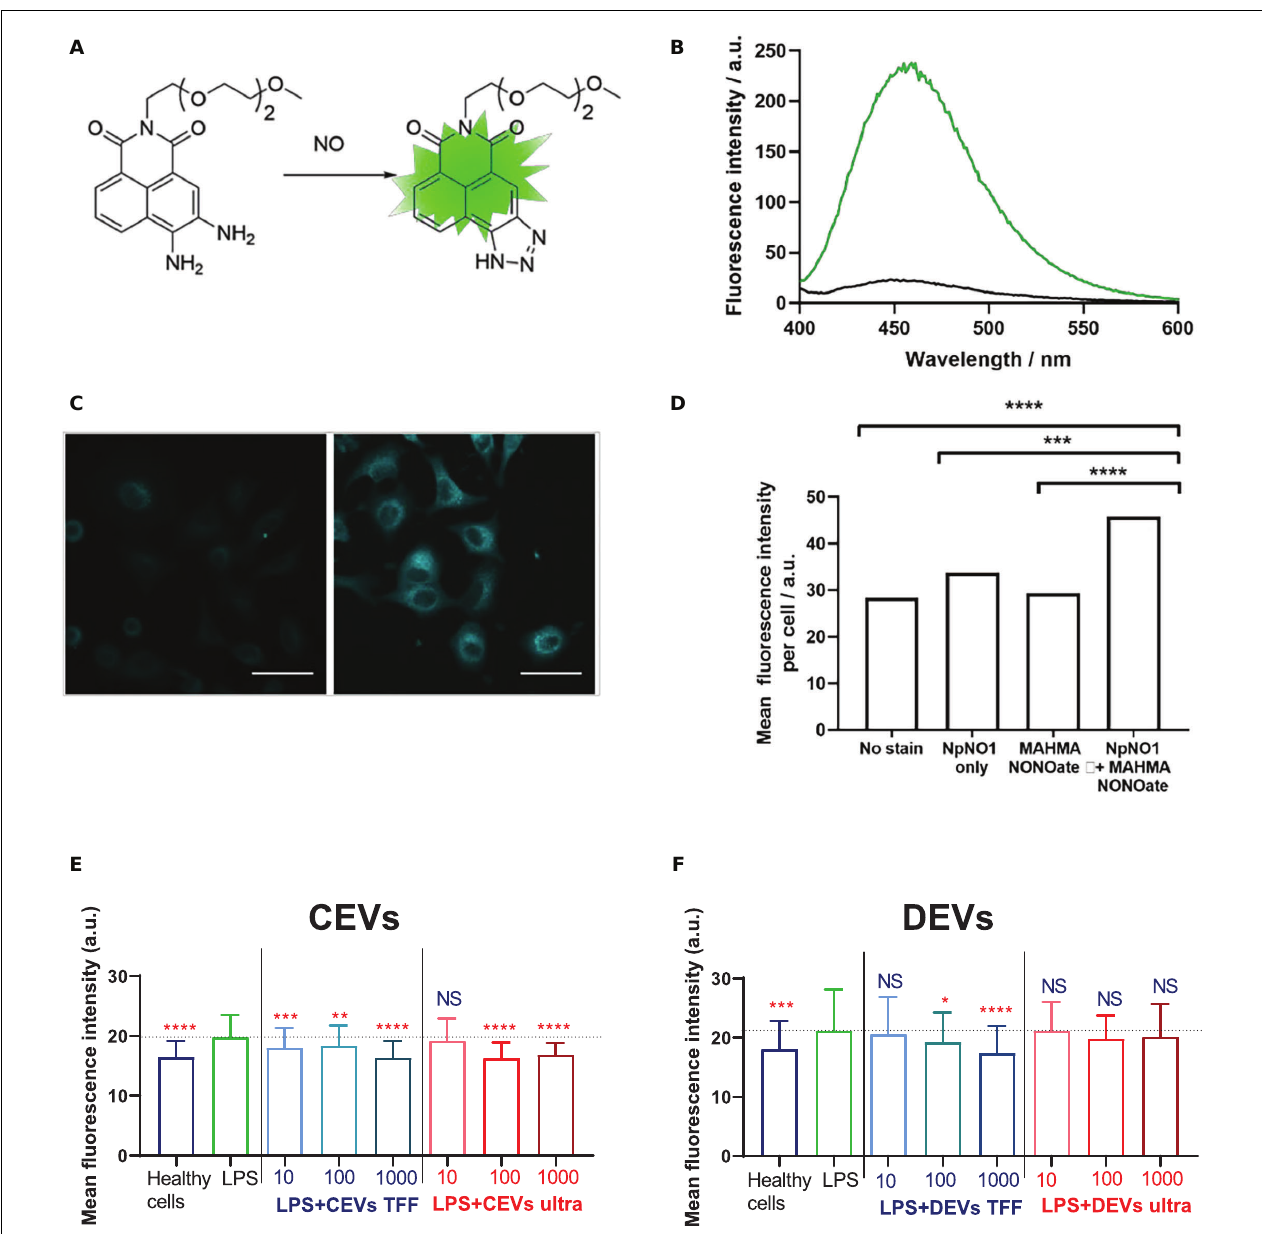
FIGURE 7 | A novel, water soluble fluorescent sensor for intracellular nitric oxide (NO) and assessing NO levels in BEAS-2B cells. (A) Water-soluble NO sensor NpNO1 and the product of its reaction with nitric oxide to give a fluorescent triazole derivative. (B) Fluorescence emission response of NpNO1 (10 µ M) in the presence of diethylamine NONOate (1 mM). (C) Representative micrographs of A549 cells treated with NpNO1 (50 µ M) in the absence (left) and presence (right) of MAHMA NONOate (5 mM). Scale bar represents 50 µ m. (D) Mean fluorescence intensity of A549 cells treated as indicated measured across at least three different field of views in each of the three independent experiments performed ( n = 3). MAHMA NONOate, (Z)-1-{N-methyl-N-[6-(N-methylammoniohexyl)amino]}diazen- 1-ium-1,2-diolate, an NO donor. BEAS-2B cells were “injured” with 10 µ g/ml of LPS and dosed with (E) CEVs isolated using TFF and ultracentrifugation and (F) DEVs isolated using TFF and ultracentrifugation. Statistical significance was determined by ordinary one-way ANOVA, followed by Dunn’s multiple comparisons test for pair-wise comparisons, n = 3. Statistical significance shown was between LPS treatment and other groups. ∗ P < 0.1; ∗∗ P < 0.01; ∗∗∗ P < 0.001; ∗∗∗∗ P < 0.0001; NS, not significant. Error bars denote standard deviation (SD). The dash line represents the mean level of the LPS